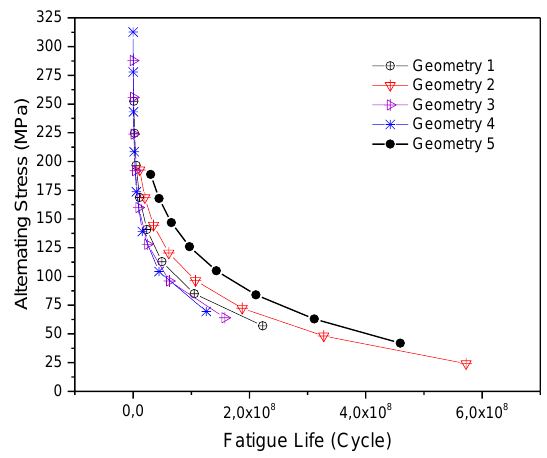
Figure 16. Relationship Between Alternating Stress and Fatigue Life of Each Geometry Figure 16: Relationship between alternating stress and fatigue life of each geometry